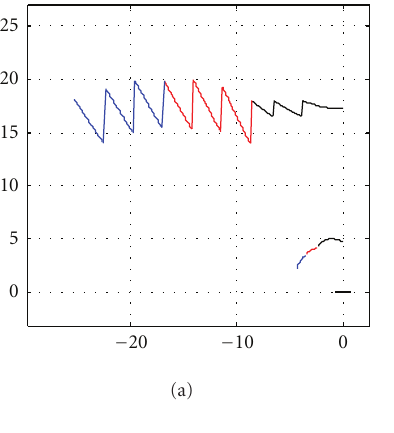
Figure 6: Schematic drawing of the secondary lens whose T surface is designed as cone shaped.